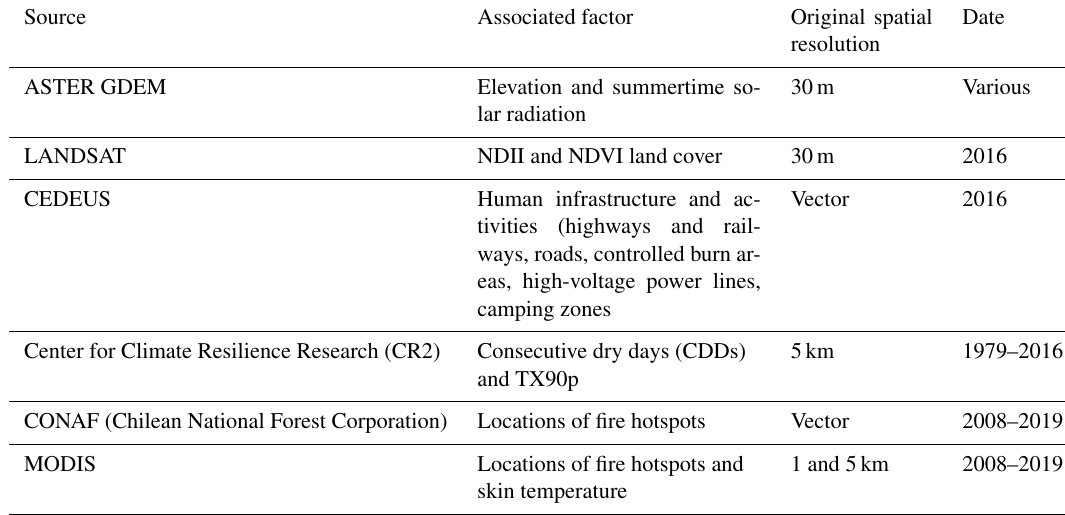
Table 1. Data sources of satellite products used in this